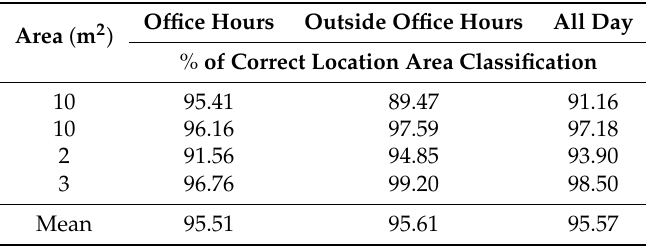
Table 3. Experimental results with an IoT testbed using Wirepas connectivity with 60 fixes per second and static